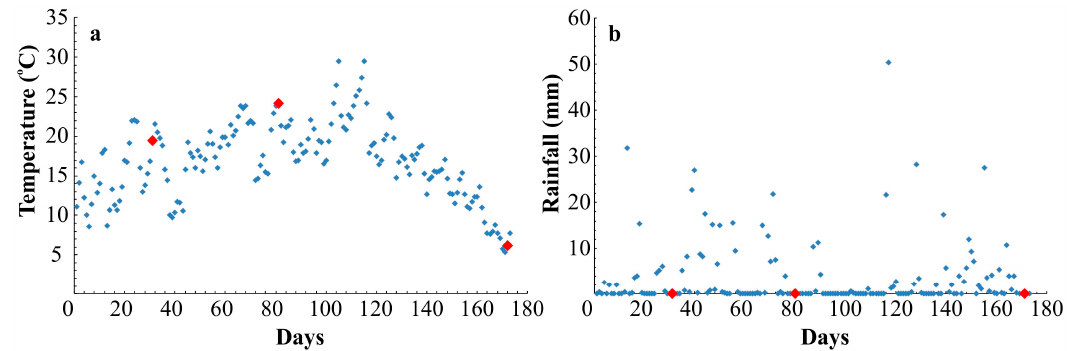
Figure 2. Temperature ( a ) and rainfall ( b ) in the study period, and 30 days before the first sample collection (red points indicate sampling days).